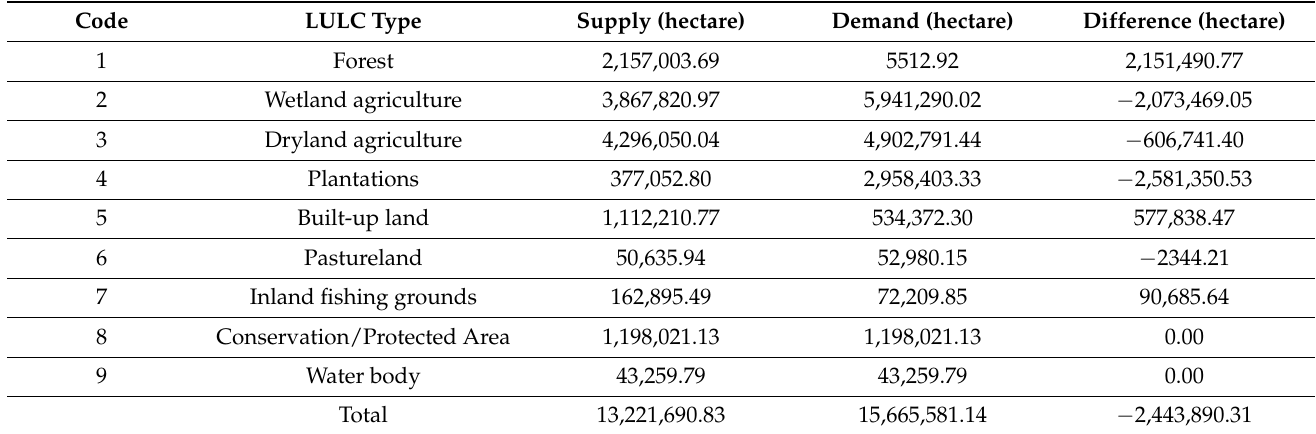
Table 11. Allocation fulfillment of land-use/land cover in Java Island based on the land